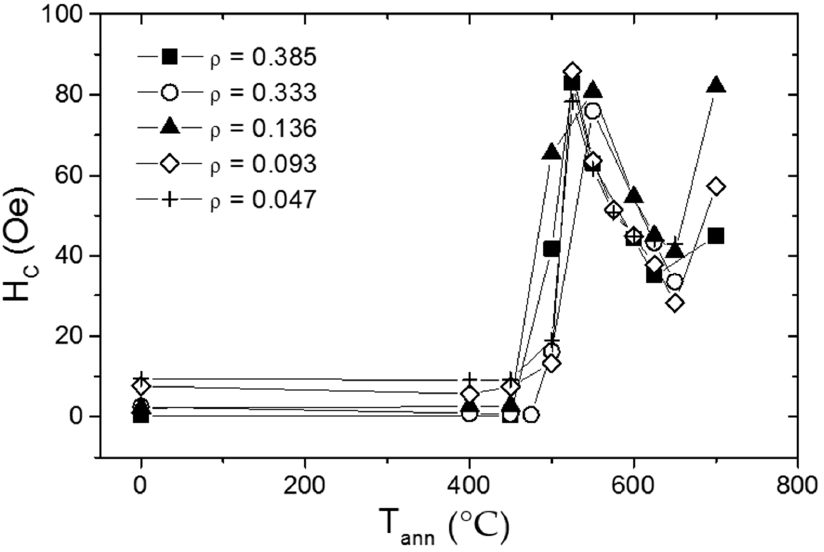
Figure 30. Effect of the annealing temperature on the coercivity of Fe 72.3 Cu 1 Nb 3.1 Si 14.5 B 9.1 microwire. Reproduced from reference [96], Figure 2. Reproduced from reference [96], Figure